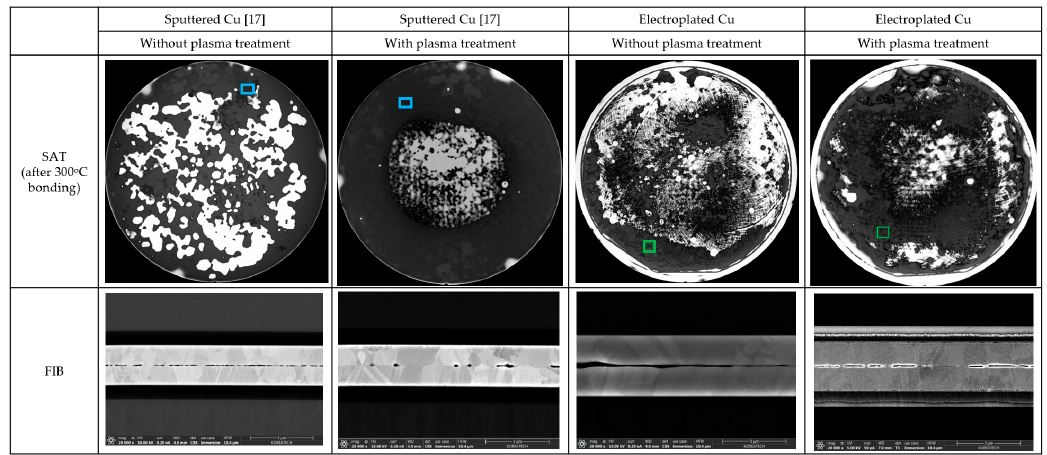
Figure 8. Bonded interface by SAT and FIB measurements.